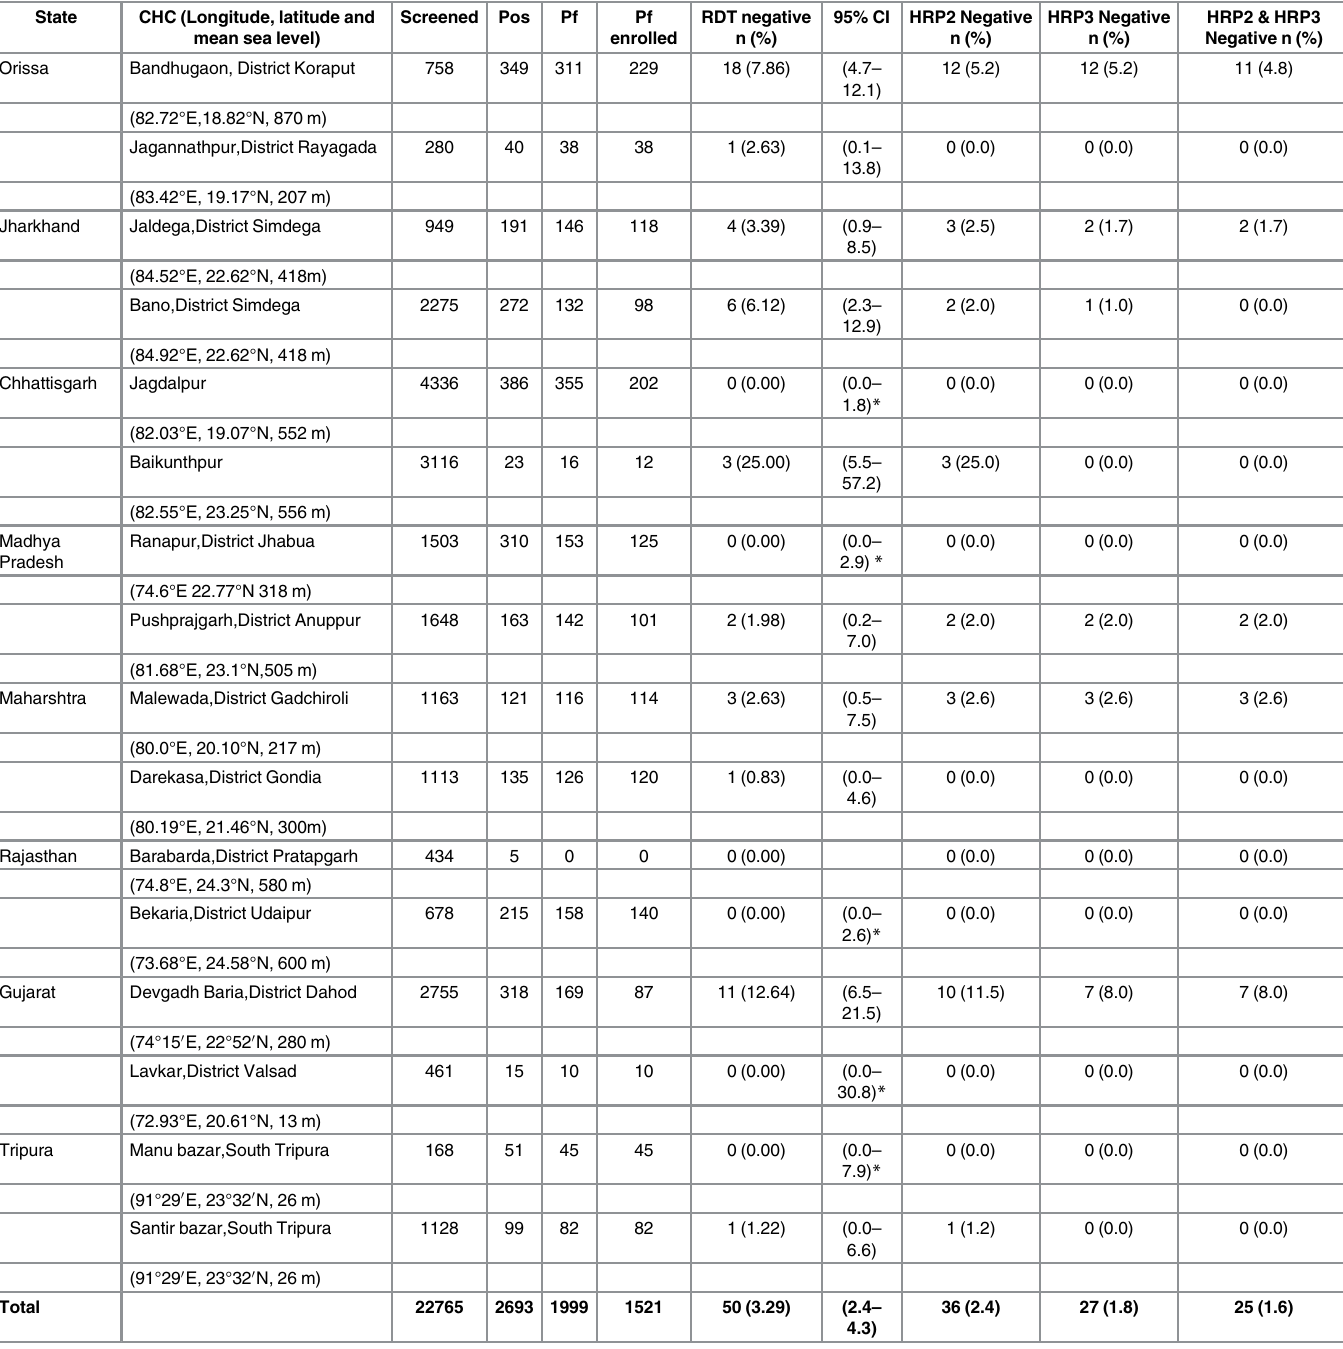
Table 2. Details of patients screening, positive, enrolled and RDT negative.